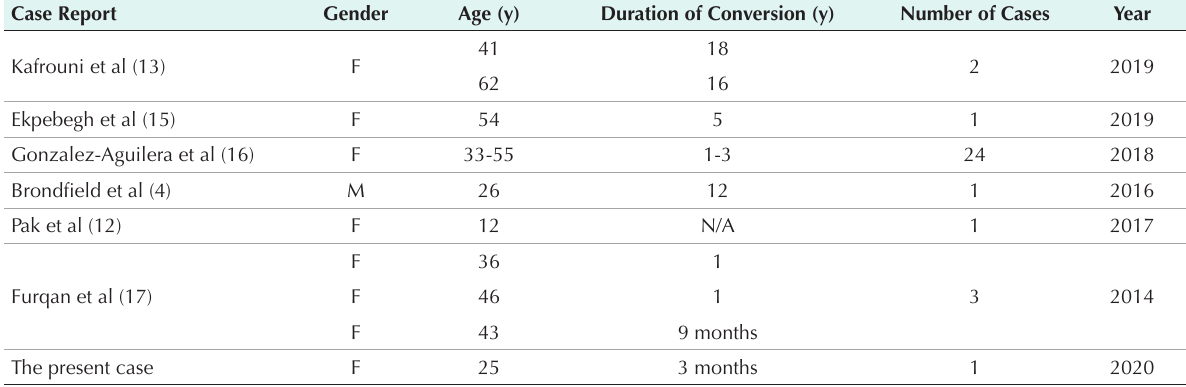
Table 1. Case Reports of the Conversion of Hashimoto Thyroiditis into Graves’ Disease and the Present